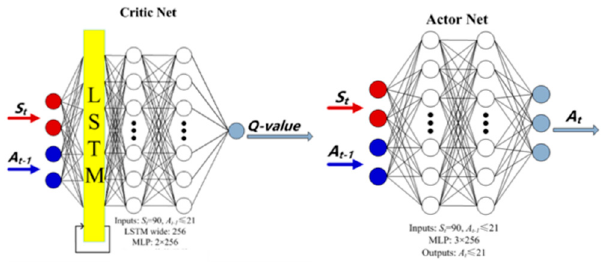
Figure 2. Critical actor network structure.